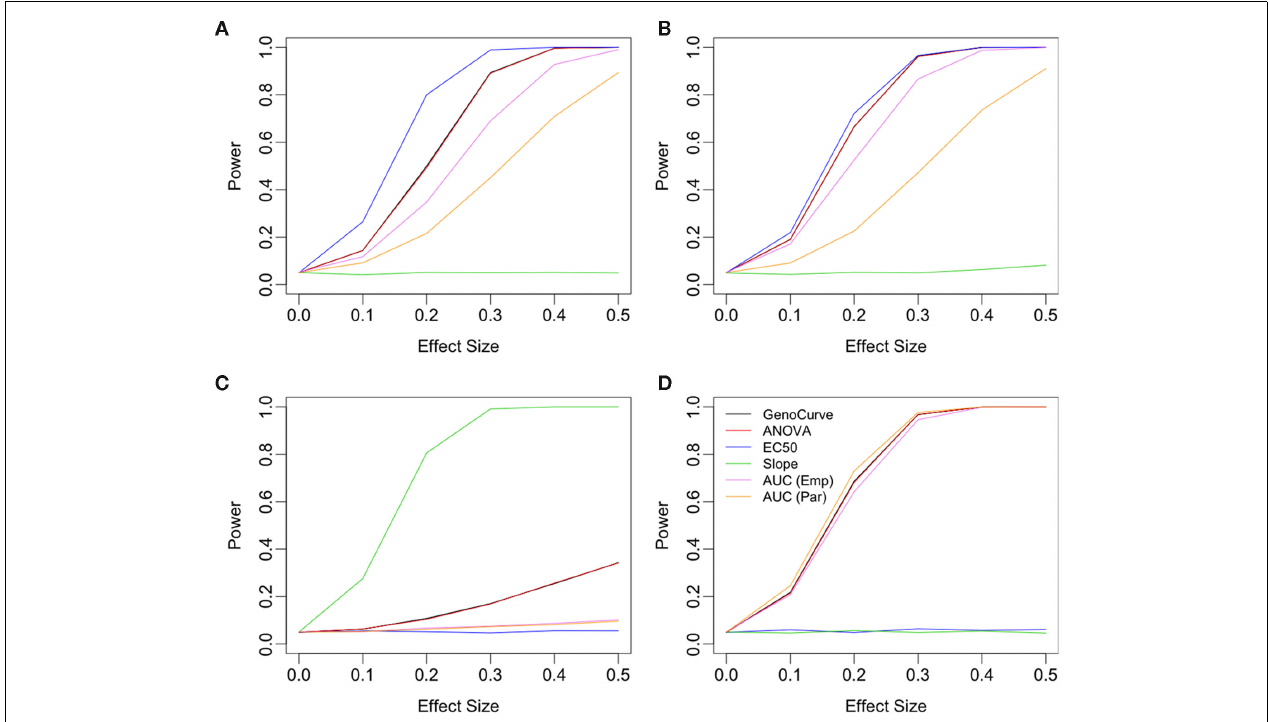
plot (C) using the Slope parameter and plot (D) using Min parameter. Plot (B) uses drug concentrations equally spaced on the log scale, while all others are equally spaced. All plots show for an additive genetic model and a MAF of 0.5.